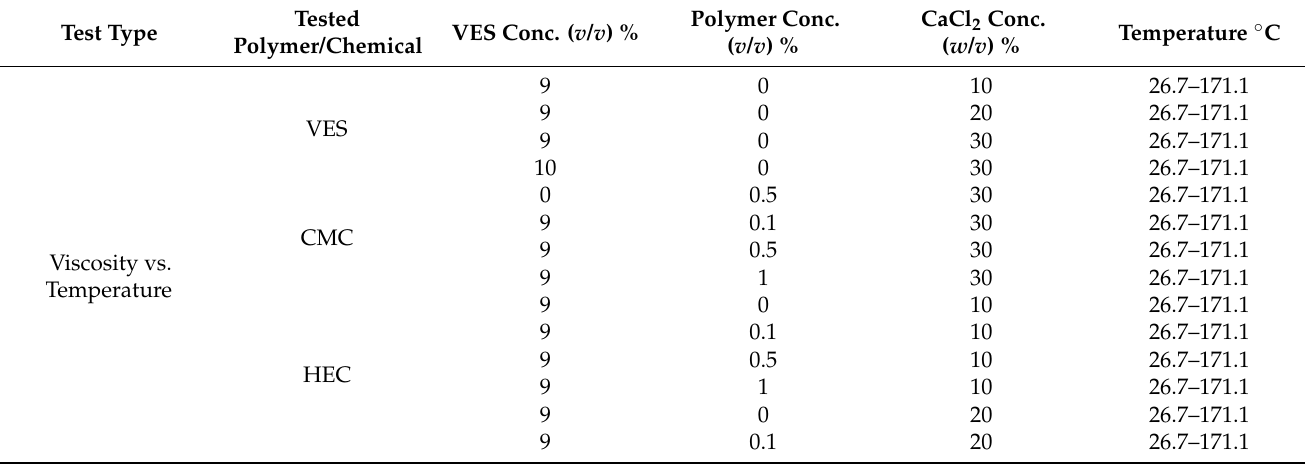
Table 1. The viscosity experiments performed at high